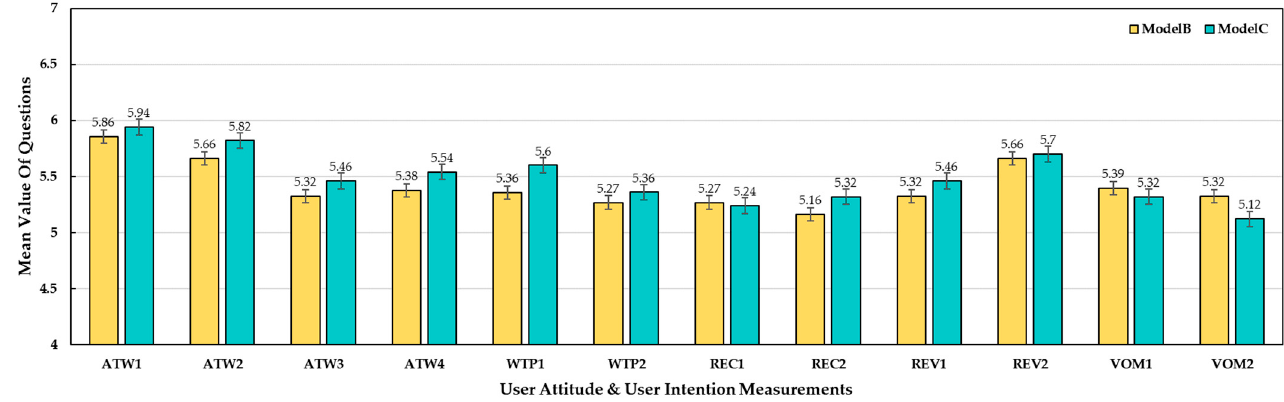
Figure 8. Comparison of user attitudes and user intentions between Model B and Model C.